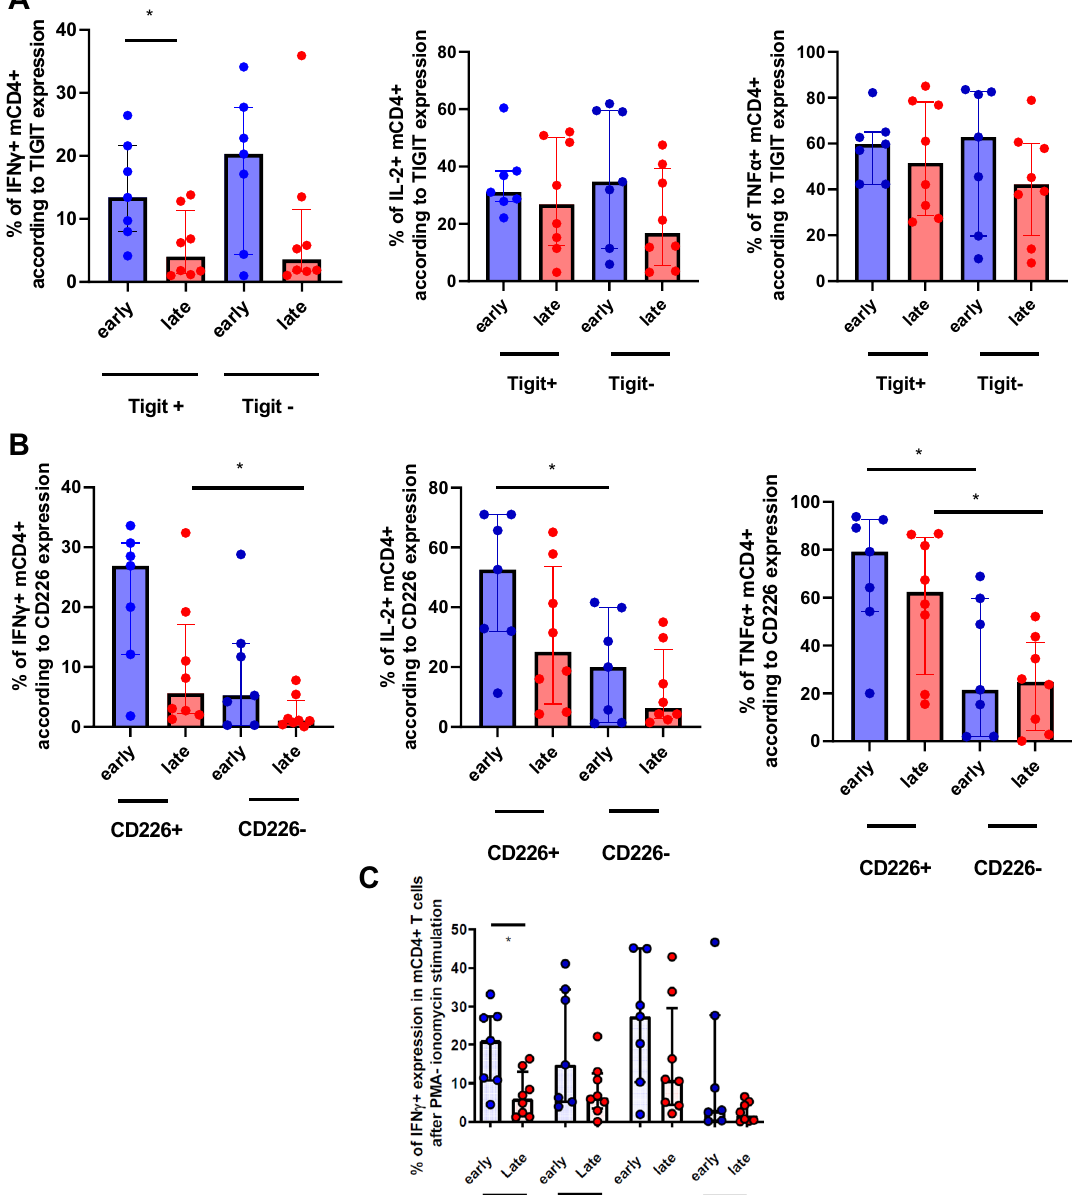
Figure 3. ( A – C ) Functional analyses according to TIGIT and CD226 expression in mCD4 + T cells in early (< 3 months) and late (> 2 years) kidney transplant patients. Comparisons were performed by an unpaired Mann-Whitney t-test (*p < 0.05, ** p < 0.01, ***p < 0.001). ( A ) Comparison of IFNγ, IL2 and TNFα production in mCD4 + T cells according to the expression of TIGIT in patients recently transplanted and those far from transplantation. ( B ) Comparison of IFNγ, IL2 and TNFα production in mCD4 + T cells according to the expression of CD226 in patients recently transplanted and those far from transplantation. ( C ) Comparison of IFNγ production in mCD4 + T cells according to the expression of TIGIT and CD226 in patients recently transplanted and those far from